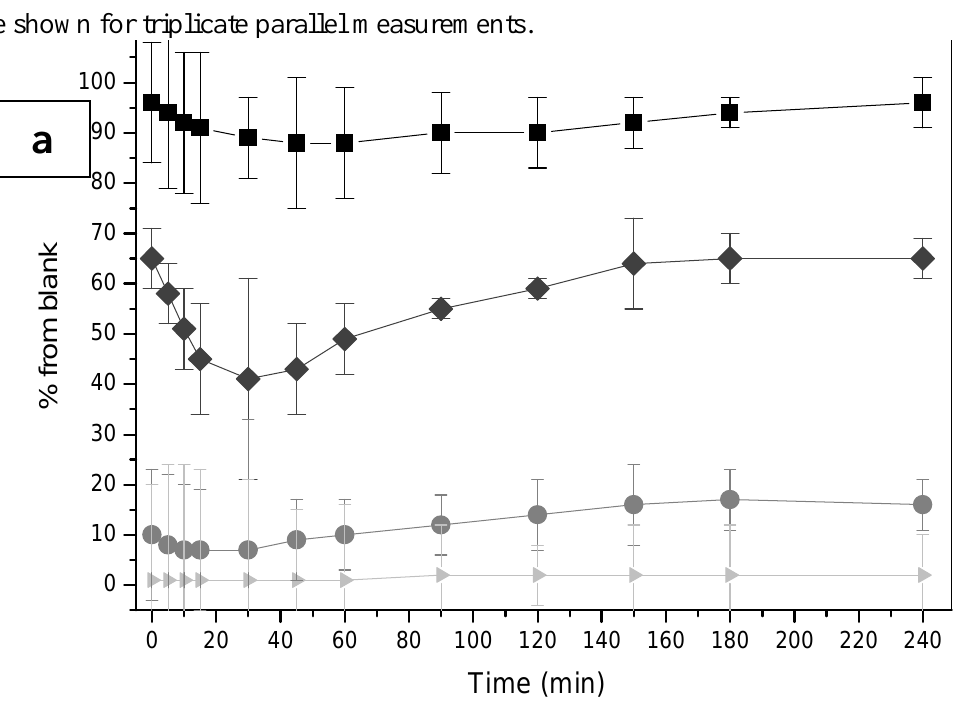
Figure 1a. Bioluminescence response to 5,6-benzoflavone in real-time monitoring during exposure of 4 h. Squares (0.75 nM), diamonds (7.5 nM), circles (75 nM) and triangles (750 nM) denote for concentration of 5,6-benzoflavone used, respectively. The error bars are shown for triplicate parallel measurements.